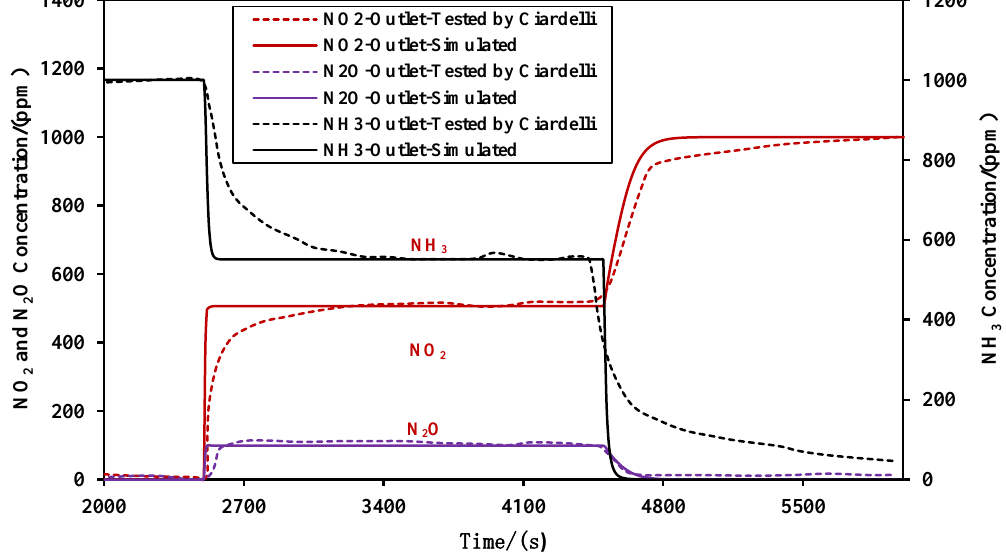
Figure 20. The change of outlet concentration of each component in the SCR system over time.